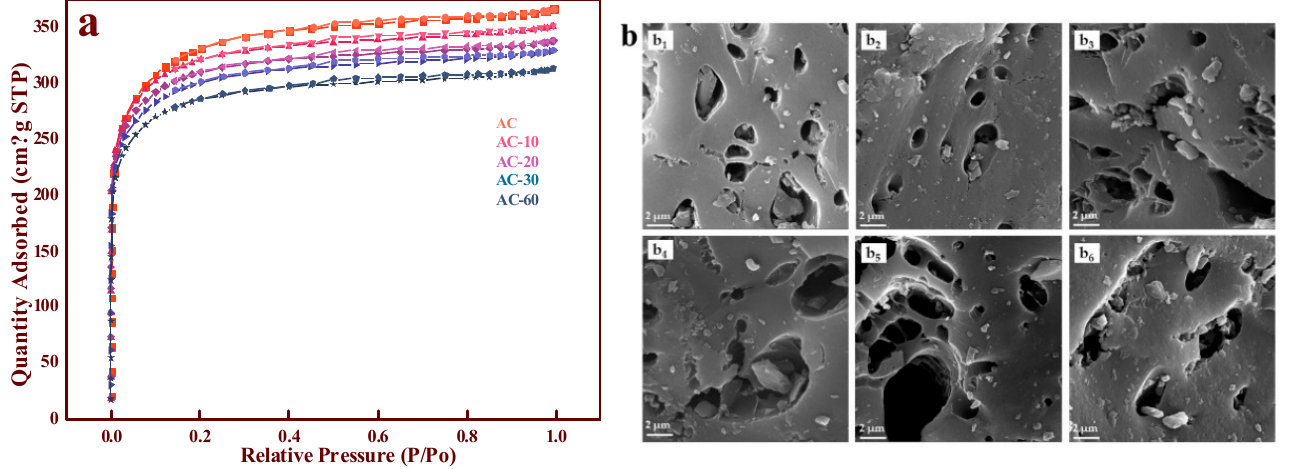
Table 1. Pore structures of the supports before and after ozone treatments at different durations. BET Surface Area